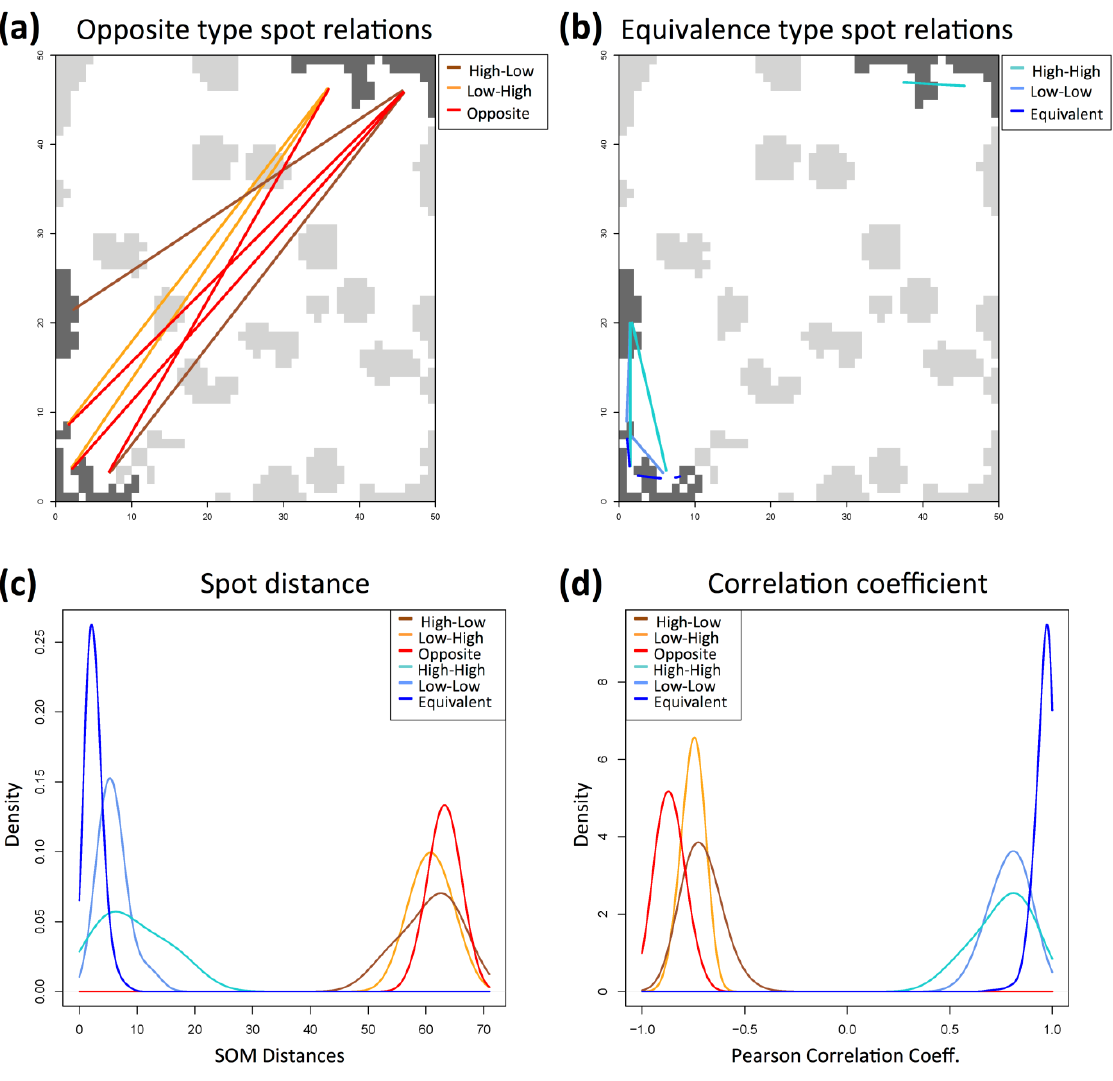
Figure 8: Spot module relations derived from metagene implications. See description of Figure-7 for further